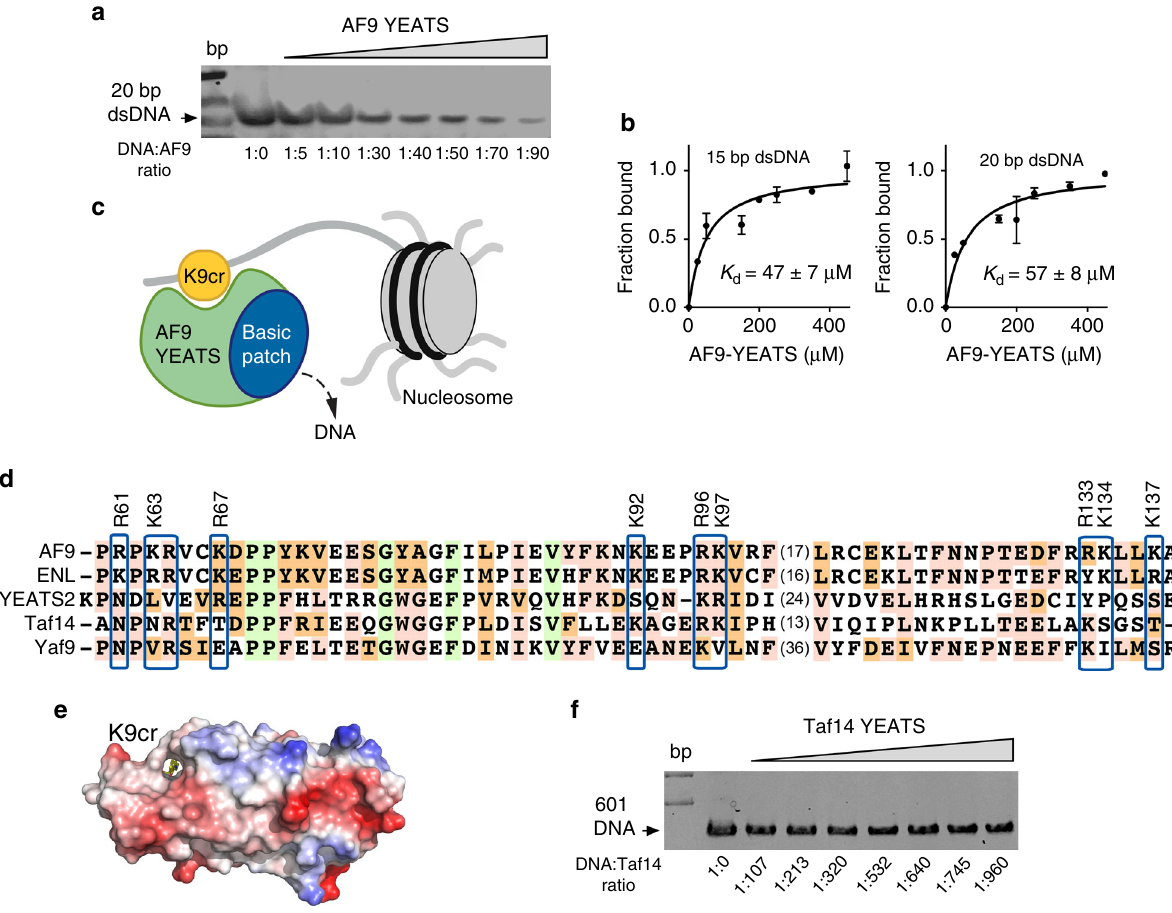
Fig. 7 Bivalent binding of AF9-YEATS is not conserved in Taf14-YEATS. a EMSA with 5 pmol/lane 20 bp dsDNA incubated with increasing amounts of AF9-YEATS. b Binding curves used to determine K d for the DNA:AF9-YEATS complex by EMSA. The band of free DNA was used for quanti fi cation of the complex formation. Binding constants are obtained from duplicate measurements as mean ± standard error. c A schematic of the bivalent interaction of AF9-YEATS with histone H3K9cr and DNA. d Alignment of the YEATS domain sequences: absolutely, moderately, and weakly conserved residues are colored green, orange, and pink, respectively. Positively charged residues in three patches are indicated by blue boxes. The residues of AF9-YEATS mutated in this study are labeled. e Electrostatic surface potential of Taf14-YEATS in complex with the H3K9cr peptide. f EMSA with 1.88 pmol/lane 601 DNA and increasing concentration of